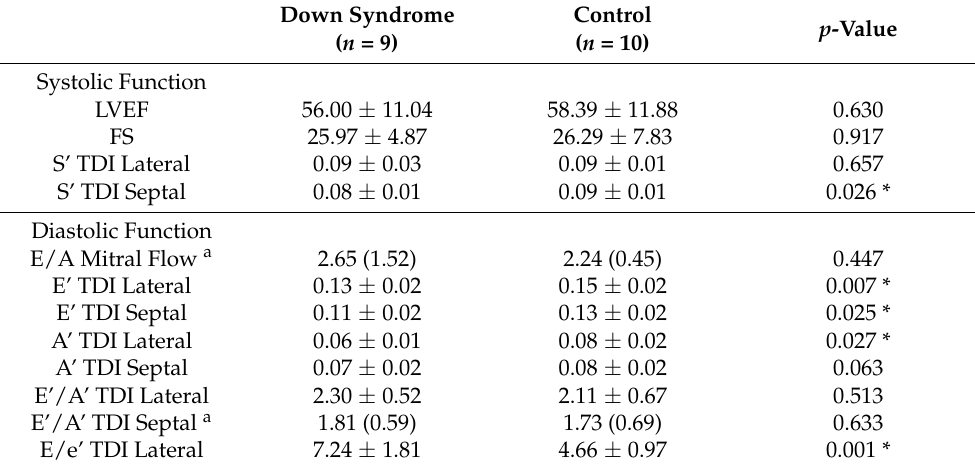
Table 2. Echocardiograph